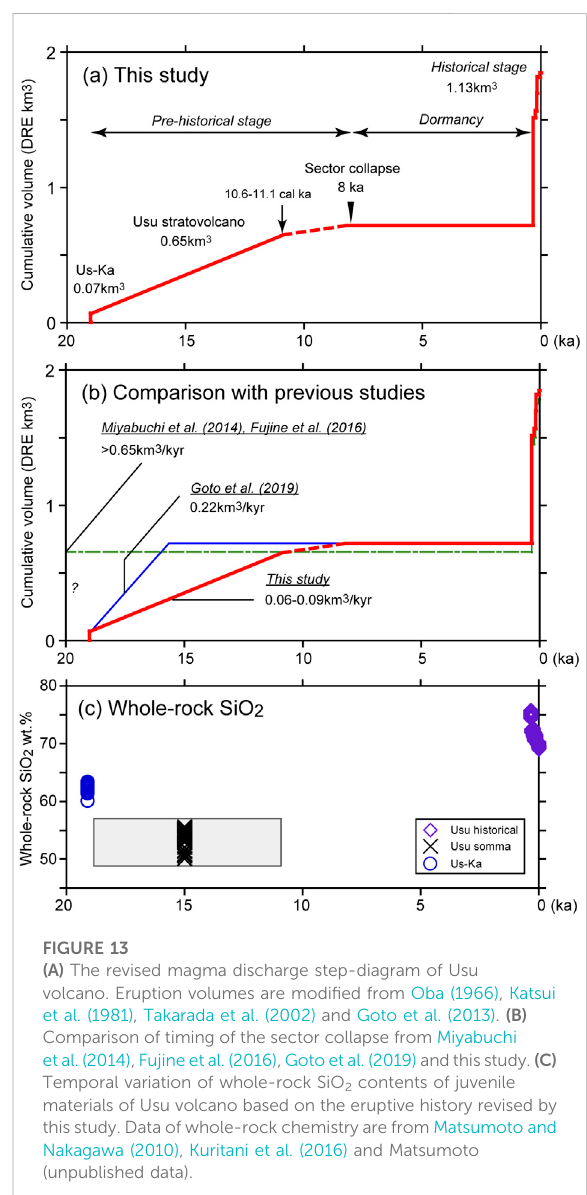
FIGURE 13 (A) The revised magma discharge step-diagram of Usu volcano. Eruption volumes are modi fi ed from Oba (1966), Katsui et al. (1981), Takarada et al. (2002) and Goto et al. (2013). (B) Comparison of timing of the sector collapse from Miyabuchi etal.(2014),Fujineetal.(2016),Gotoetal.(2019)andthisstudy. (C) Temporal variation of whole-rock SiO 2 contents of juvenile materials of Usu volcano based on the eruptive history revised by this study. Data of whole-rock chemistry are from Matsumoto and Nakagawa (2010), Kuritani et al. (2016) and Matsumoto (unpublished